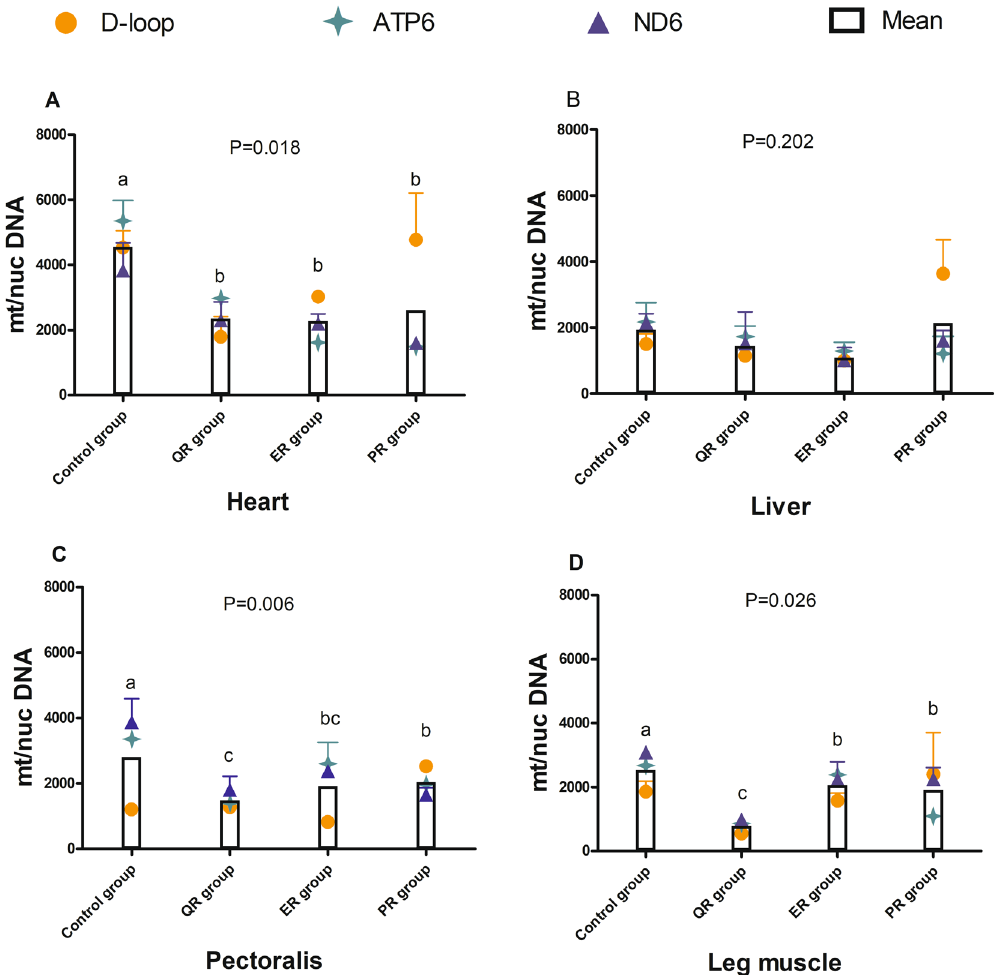
Figure 6. Effects of feed restriction on the mtDNA copy number of 42 d broilers in different tissues. ( A ) Heart; ( B ) liver; ( C ) pectoralis; ( D ) leg muscle. mt/nucDNA = mtDNA relative to nuclear DNA ( GCG ) copy number. P group = 0.002; P group × tissue = 0.472. Different letters indicate P < 0.05, and the same or no letter indicates P > 0.05. The control group was fed a conventional diet ad libitum, the QR group was fed a conventional diet between 8:00–13:00 from 8–21 d, the ER group was fed a 15% energy-restricted diet ad libitum from 8–21 d, and the PR group was fed a 15% protein limited diet ad libitum from 8–21 d. n =